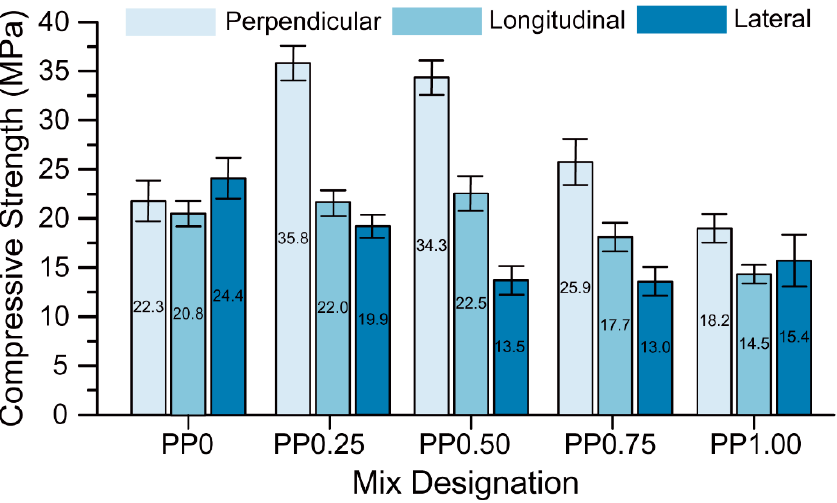
Figure 7. The compressive strength of printed specimens in different directions.